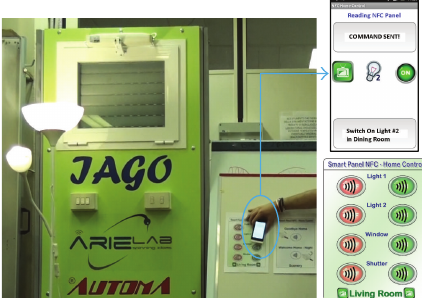
Figure 9: NFC interaction to control a single light in the home automation system: a magnified view of the Smart Panel and the application interface is provided.